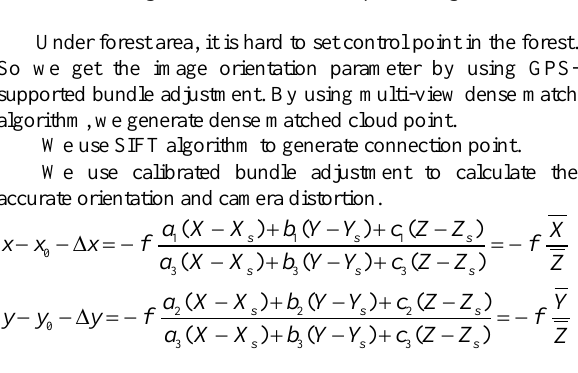
Figure 1 workflow of the